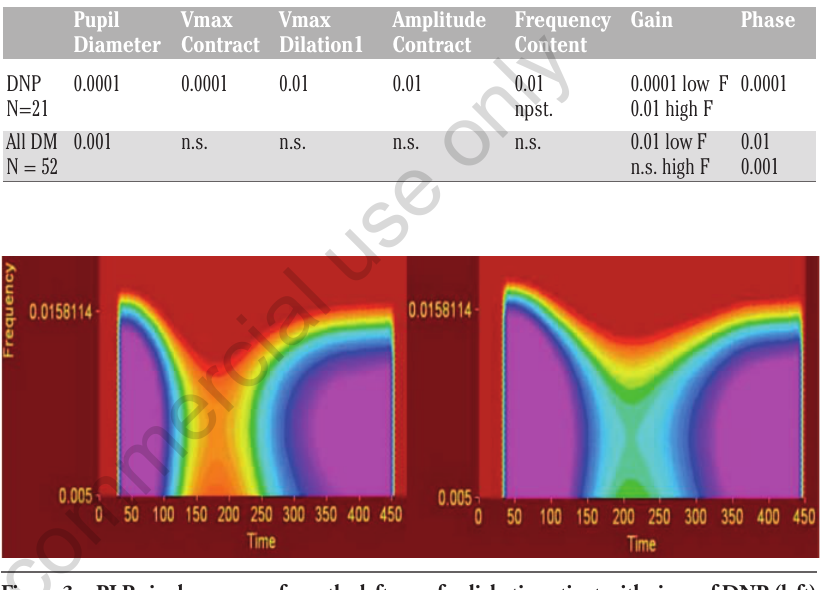
Figure 3. pPLR single response from the left eye of a diabetic patient with signs of DNP (left) compared to a normal subject (right), using short time fourier transformation (STFT) as function of time plot. A significantly larger amount of high frequency content during both pPLR phases, contraction and dilation,